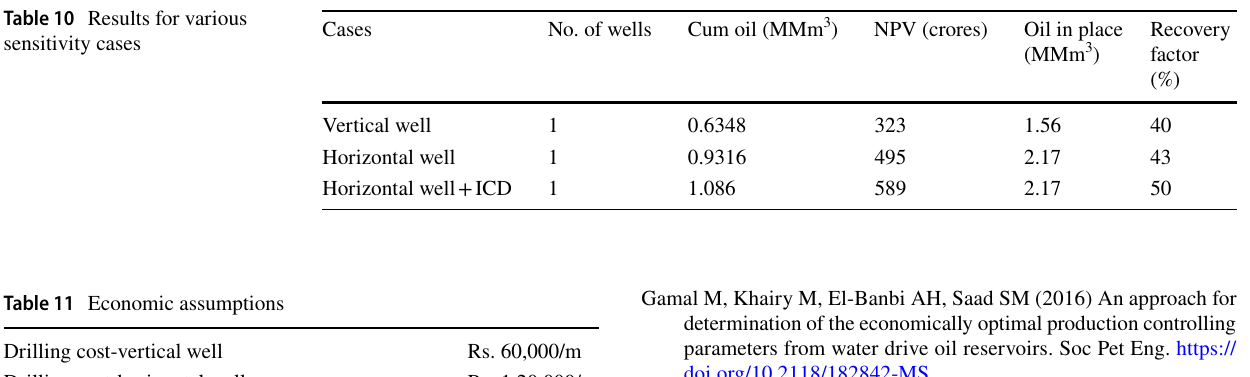
Drilling cost-vertical well Drilling cost-horizontal